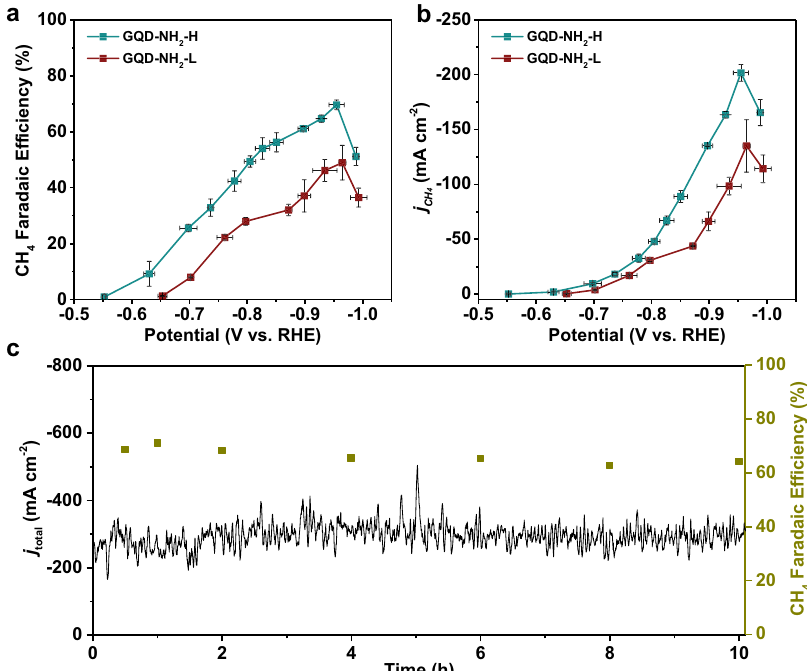
Fig. 4 CO 2 electrochemical reduction results for two NH 2 -functionalized GQDs. a and b Faradaic ef fi ciency of CH 4 ( a ) and j CH4 ( b ) as a function of applied potential for GQD-NH 2 -H ( a ) and GQD-NH 2 -L ( b ). c The ten-hour performance of GQD-NH 2 -H tested under − 0.95 V. The error bars represent the standard deviation from at least three independent